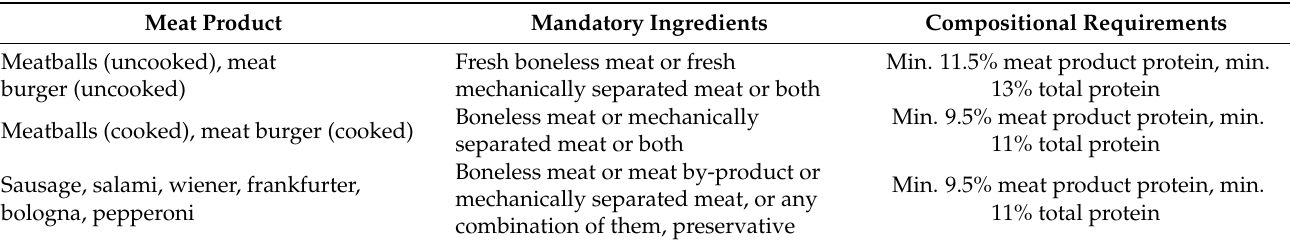
Table 1. Standards for specific edible meat products in